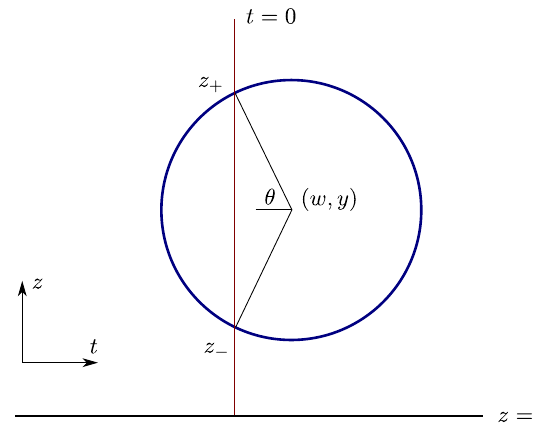
Figure 6 . Near-AdS space without